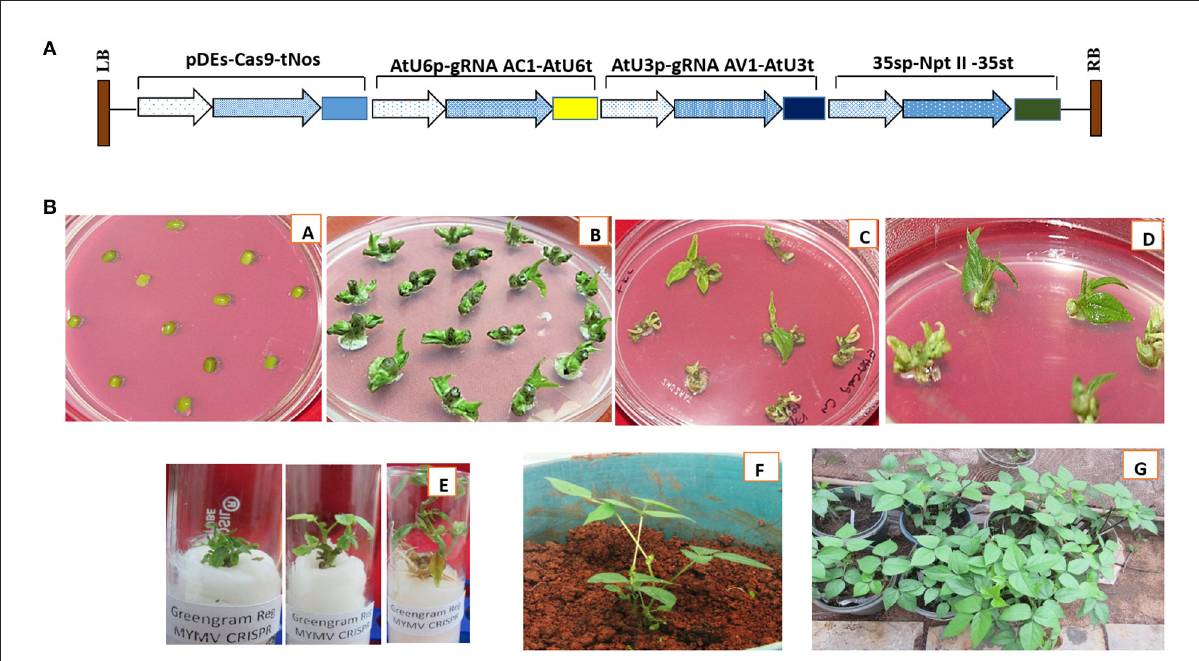
FIGURE2 (A) Cloning of guide RNAs and Cas9 exonuclease in pMDC100 vector: The image depicted shows the single guide locations in MYMV genome and T-DNA region of pMDC100 vector harboring Cas9 nuclease expression cassette, gRNA1, gRNA2, and Kanamycin selectable marker. (B) Agrobacterium EHA105 mediated greengram transformation using CRISPR construct and cotyledonary nodes as explants: (A) seed germination, (B) Co cultivation of EHA105 with cotyledonary node explants, (C) selection on kanamycin medium, (D) resistant plants growing regeneration